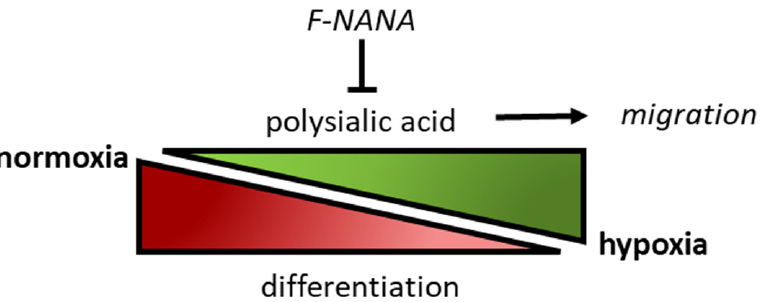
Figure 9. Schematic representation of the role of PSA and the effects of its inhibition in GBM cells. The figure shows the inverse correlation between the levels of PSA (polysialic acid) and the degree of differentiation of GBM cells. Low oxygen concentrations upregulate the levels of PSA in GBM cells, thus inducing their dedifferentiation and migration. All these events can be inhibited by interfering with the synthesis of PSA by treating GBM cells with F-NANA.